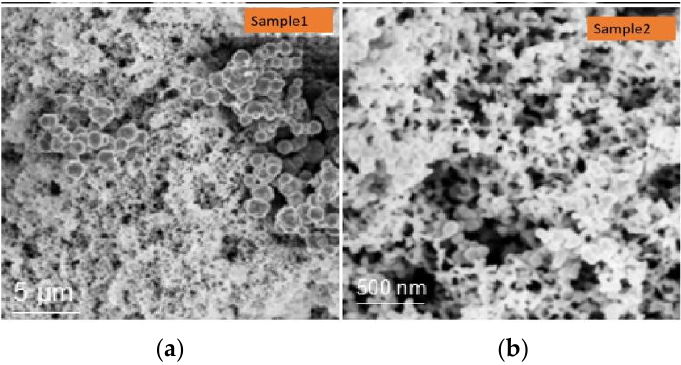
Figure 5. SEM of sample in different resolutions. ( a ) 5 μ m. ( b ) 0.5 μ m.